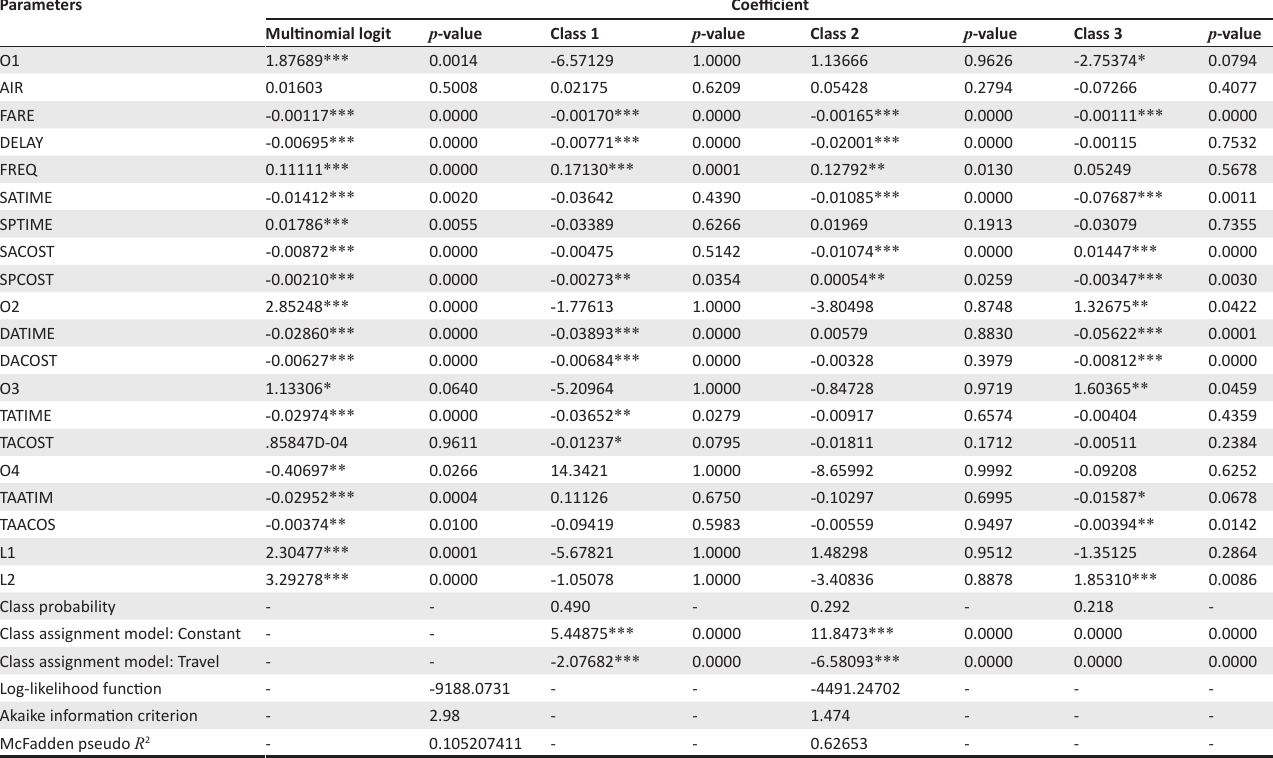
TABLE 3: Nlogit estimation results based on respondents’ preferences.